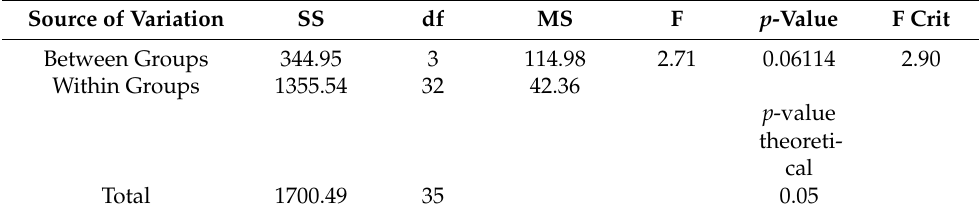
Table 4. Statistical results obtained using ANOVA for recovery values calculated with the four methods. Source of Variation SS df MS F p -Value F Crit Between Groups